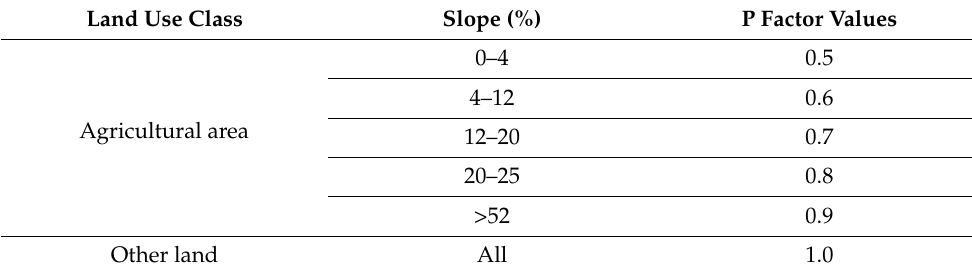
Table 4. P factor for different land use /land cover based on slope gradient [38].